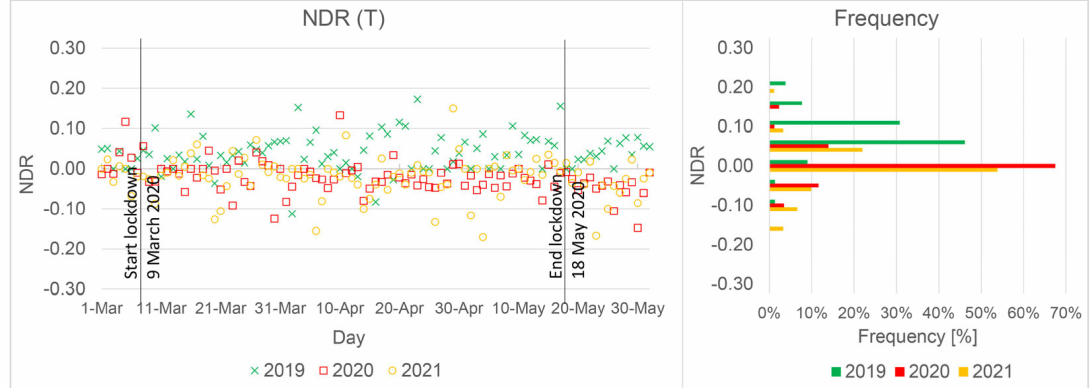
Figure 11. Comparison of NDR for temperature (S3 datalogger) during March, April and May for the years 2019, 2020 and